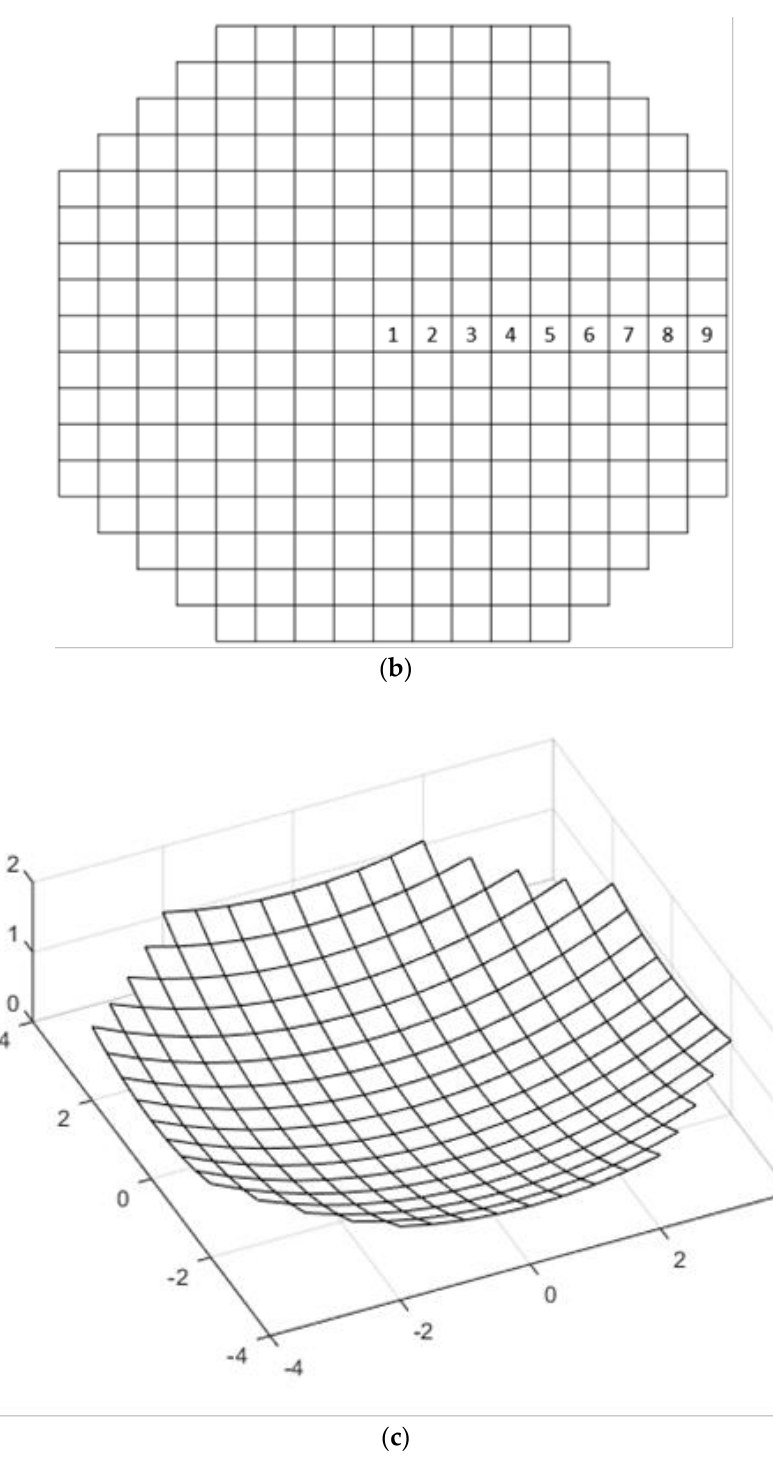
Figure 1. Schematic diagram of reflected mirrors in a combined dish system: ( a ) main view; ( b ) top view; ( c ) spatial view.